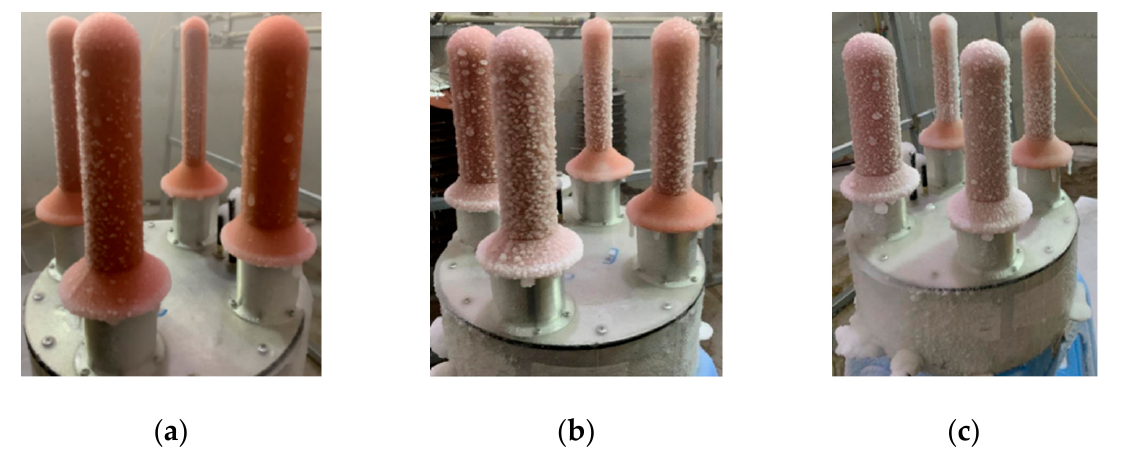
Figure 12. Diagram of icing shape of multi-conductors: ( a ) t = 0.5 h; ( b ) t = 1.5 h; ( c ) t = 3 h.